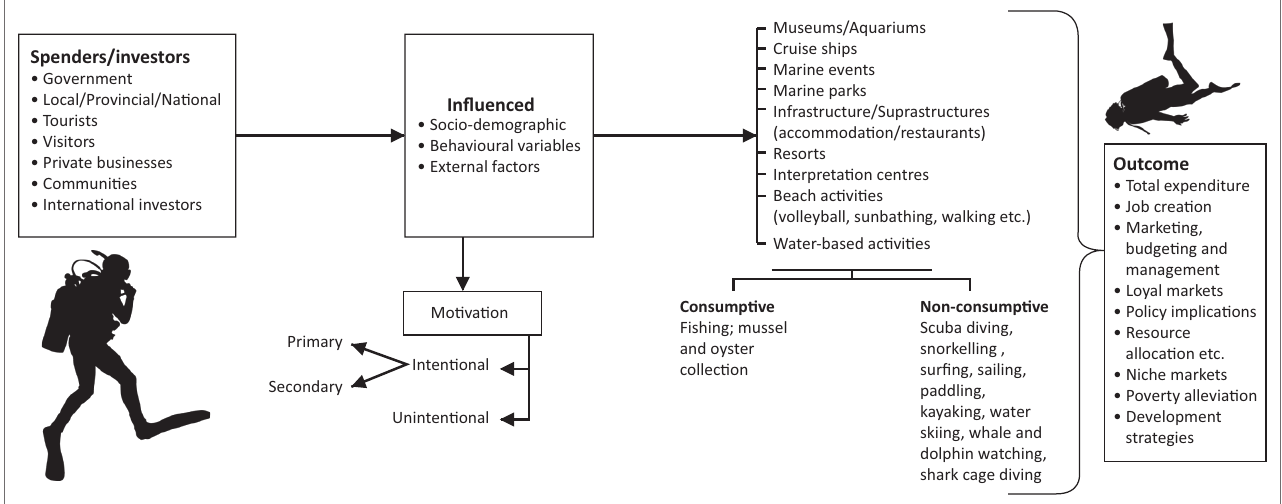
FIGURE 1: Conceptual marine tourism